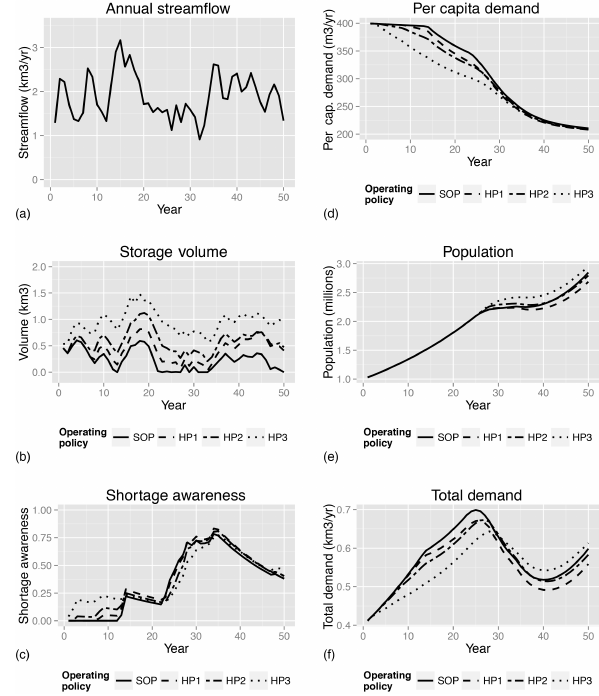
Figure 7. Model results, trial 2: (a) annual streamflow, (b) reser- voir storage volume, (c) public shortage awareness, (d) per capita demand, (e) annual city population, (f) total